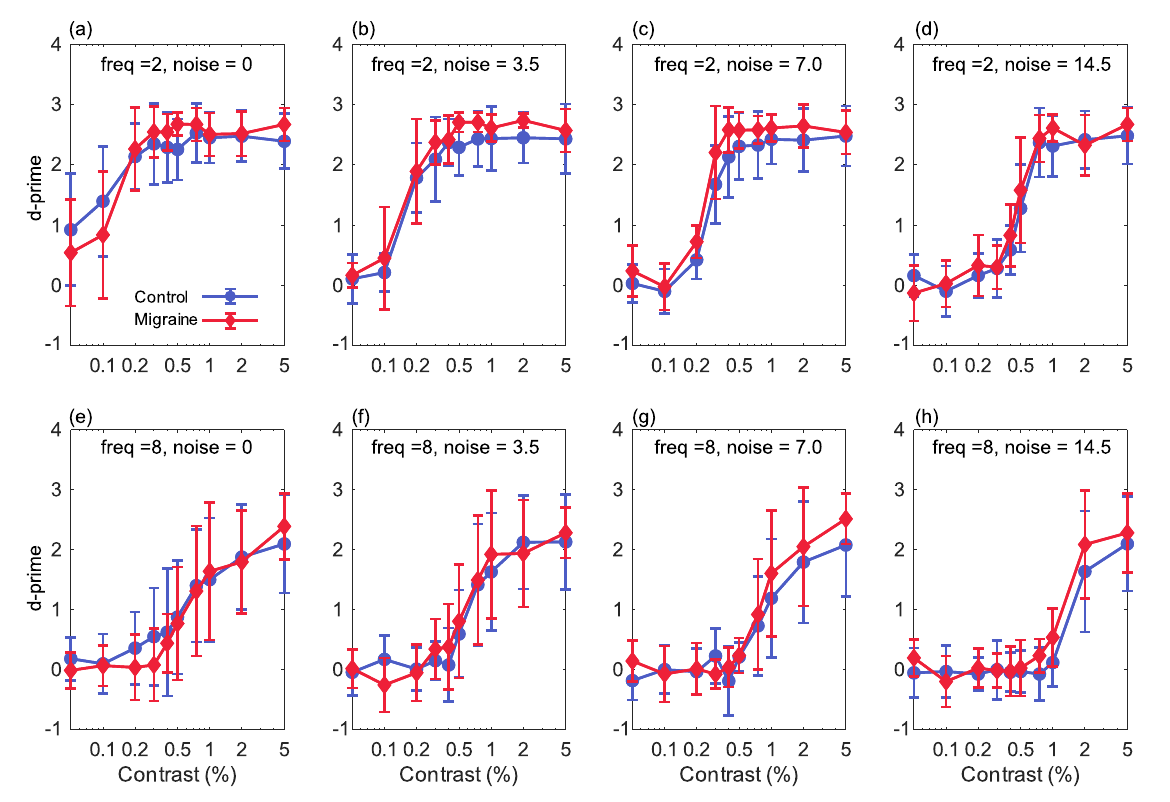
Figure 2. The results showing percentage Michelson contrast, spatial frequency against d’ (sensitivity) for the 2 cpd stimuli (top row) and the 8 cpd stimuli (bottom row), for increasing levels of Gaussian noise (n): ( a , e ) 0 noise (sigma of the Gaussian function = 0), ( b , f ) sigma is 3.5, ( c , g ) sigma is 7, ( d , h ) sigma is 14.5. Error bars show ± 1 standard